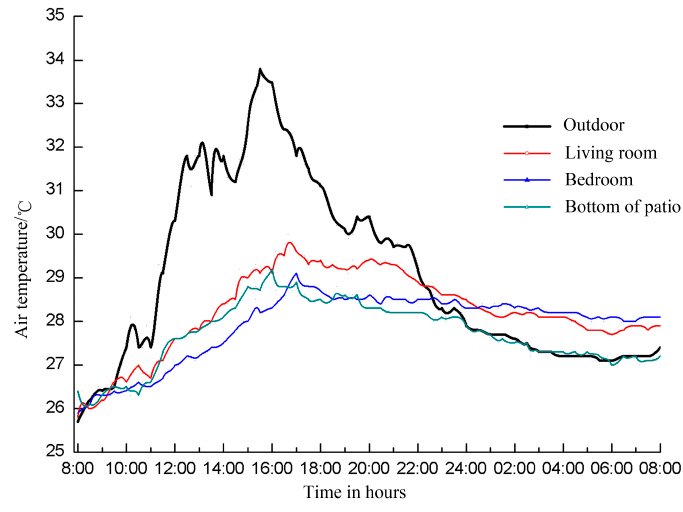
Figure 4. Comparison of temperatures.